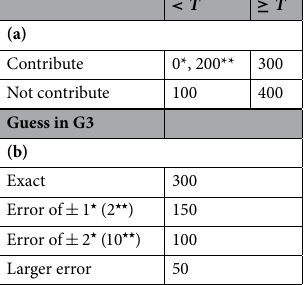
Table 1. Payoff’s structure of Game 2 (a) and Game 3 (b). (a) Game 2: payoff to a subject in the case that she contributes or not, depending on the other players exceeding or not the threshold T . The numbers are in tokens. One asterisk (*) for payoff in treatment T1 and T2, while two asterisks (**) for T3. (b) Game 3: payoff to a subject. It depends on how close the respondent’s guess is to the actual number of others in her group who T3.